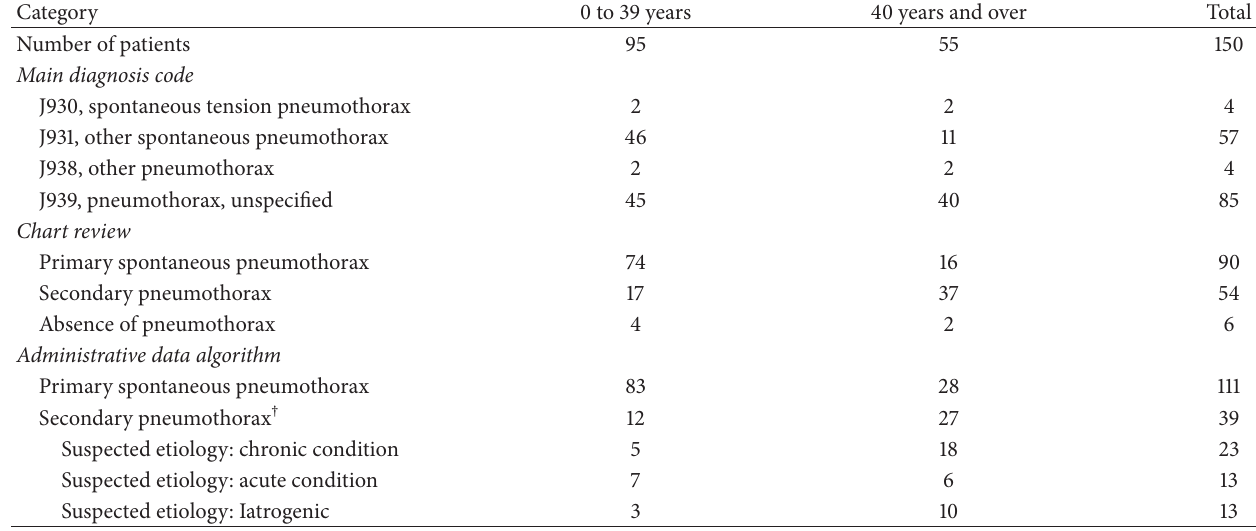
Table 2: Distribution of patients with a main diagnosis code of pneumothorax according to age group.